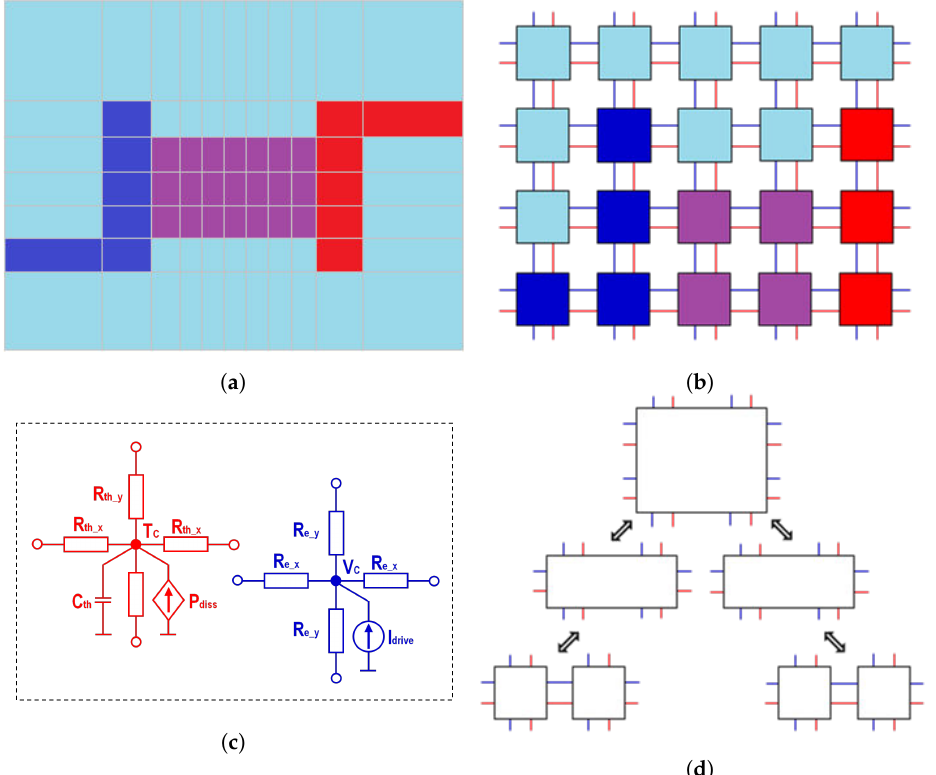
Figure 5. Operation of the custom solver (for clarity in 2D): ( a ) Dividing the model into elementary cells; ( b ) Model network built from elementary cells; ( c ) Electro-thermal elementary cell, red: thermal, blue: electrical; ( d ) Successive network